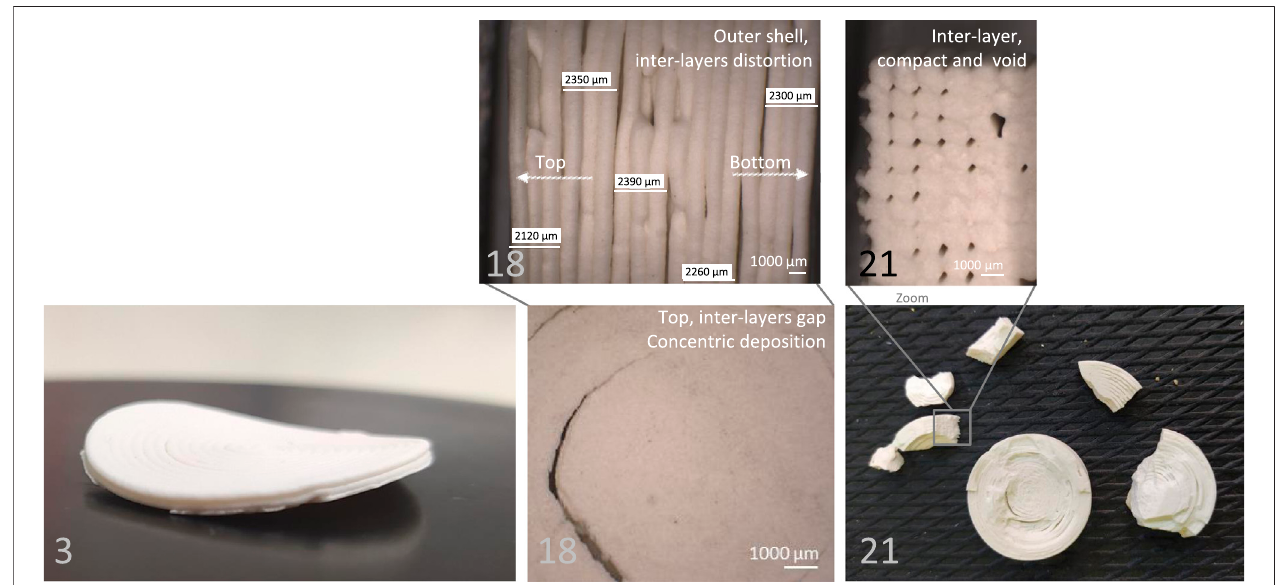
FIGURE7| Printedpawnsaftersintering,secondcampaignwithStep2:annealingat700 ° C,1 h.Theillustrations(3,18,and21 mm)showthethreetendenciesof dimensional loss: 3 mm with curled deformation, 18 mm with cracks formation and inter-layer delamination batches, and 21 mm broken parts with a zoom showing voids between inter- fi lament inside the bulk part due to the printing 3D process. Printed-layer thickness of 1 mm. Cylinders of 20 mm in diameter.